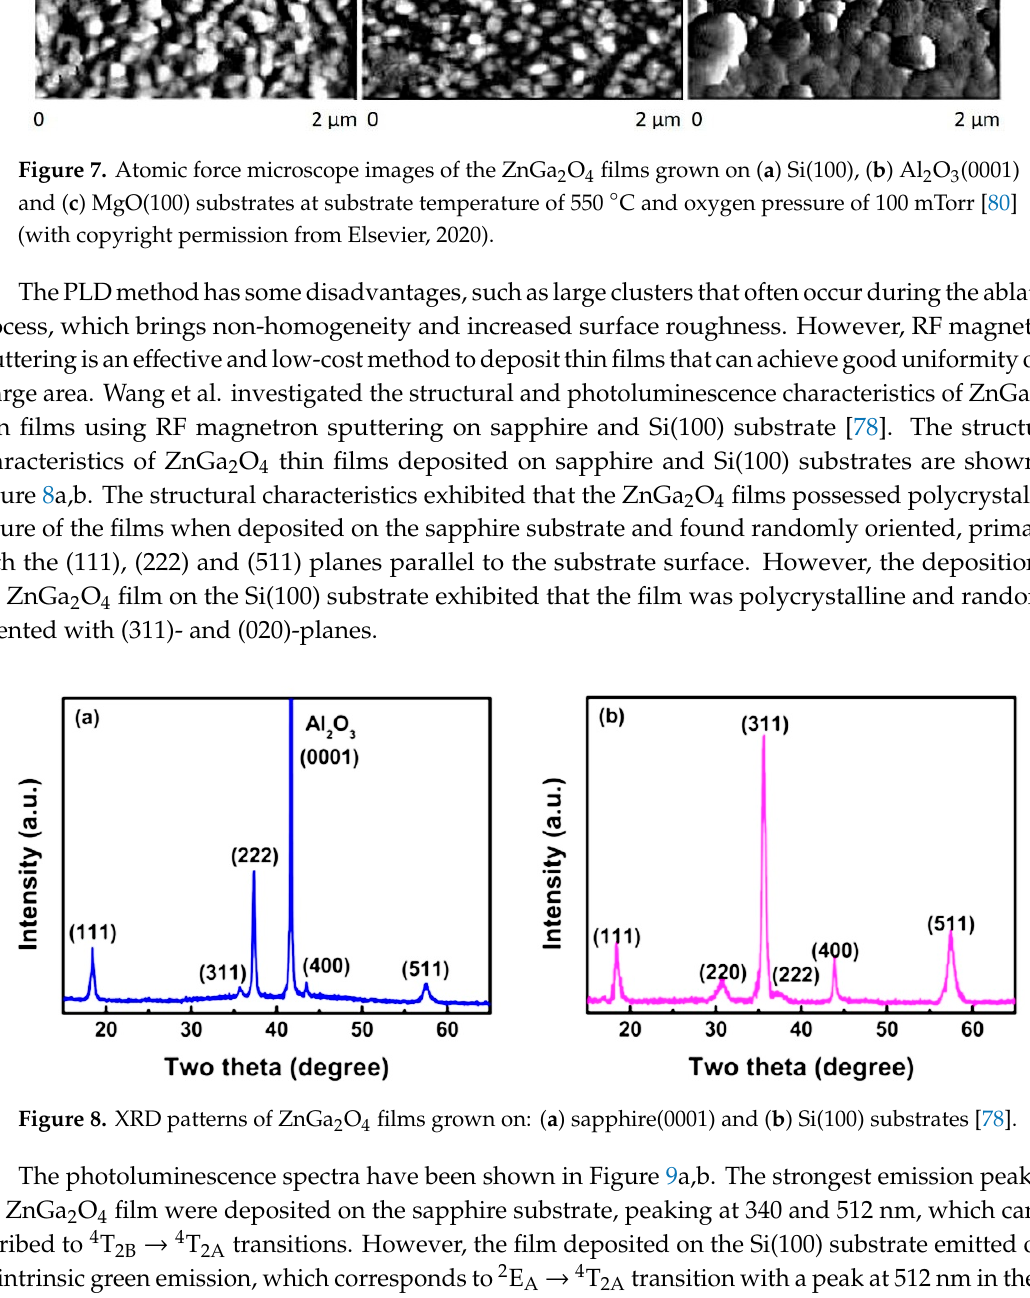
Figure 9. Room temperature PL spectra of the ZnGa 2 O 4 films deposited on: ( a ) sapphire(0001) and ( b ) Si(100) substrates [78]. 4.1.2. Effects of Substrate Temperature and Oxygen Pressure Oxygen plays an important role in the growth of ZnGa 2 O 4 thin films. If oxygen gas is insufficient during the growth, oxygen vacancies will take place in the deposited film and Zn has more possibility to diffuse out. Thus, the stoichiometry of the film will not be the same and the crystallinity will be poor. Figure 10a–d shows the structural characteristics of the ZnGa 2 O 4 film deposited at a different substrate temperatures of 650 and 700 °C, as well as with different oxygen pressures of 60 and 100 mTorr [79]. The films deposited with low oxygen temperature show a (400) ZnGa 2 O 4 peak along with another diffraction peak at 30° which corresponds to the Ga 2 O 3 phase. The introduction of additional oxygen will produce more Zn-O molecules through gas-phase collisions of Zn species with oxygen. Increasing partial oxygen pressure P(O 2 ) decreases the Zn loss in the ZnGa 2 O 4 film and a near stoichiometric single phase can be found for epitaxial ZnGa 2 O 4 films when the substrate temperature